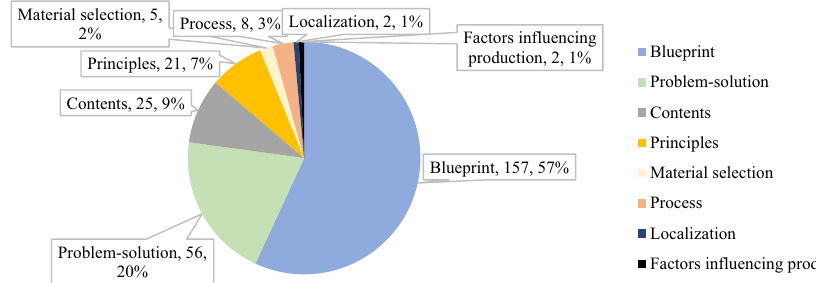
Fig. 8 Frequencies of research themes related to textbook